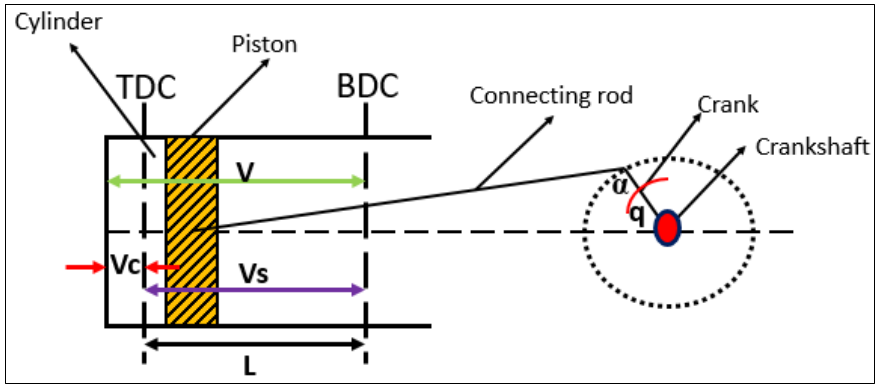
Figure 1. The basics of the engine